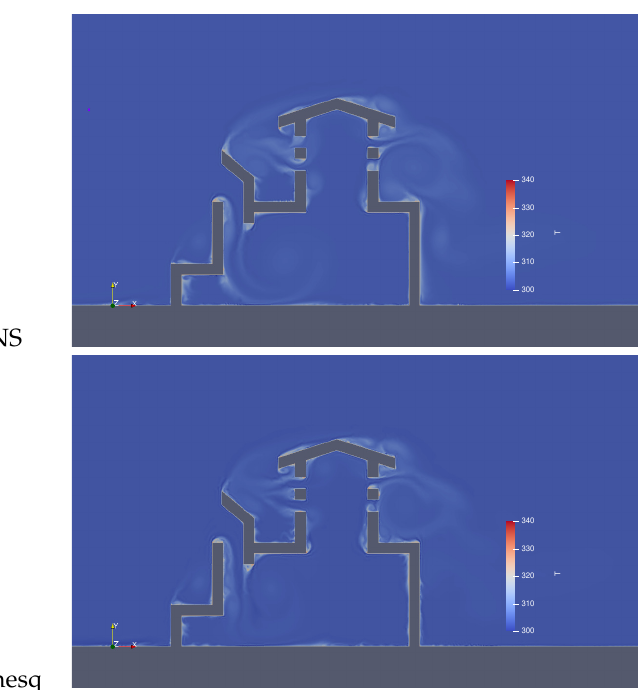
Figure 18. Wind tower 1. Temperature field obtained using the full NS and the Boussinesq model and U ∞ = 5 m/s.